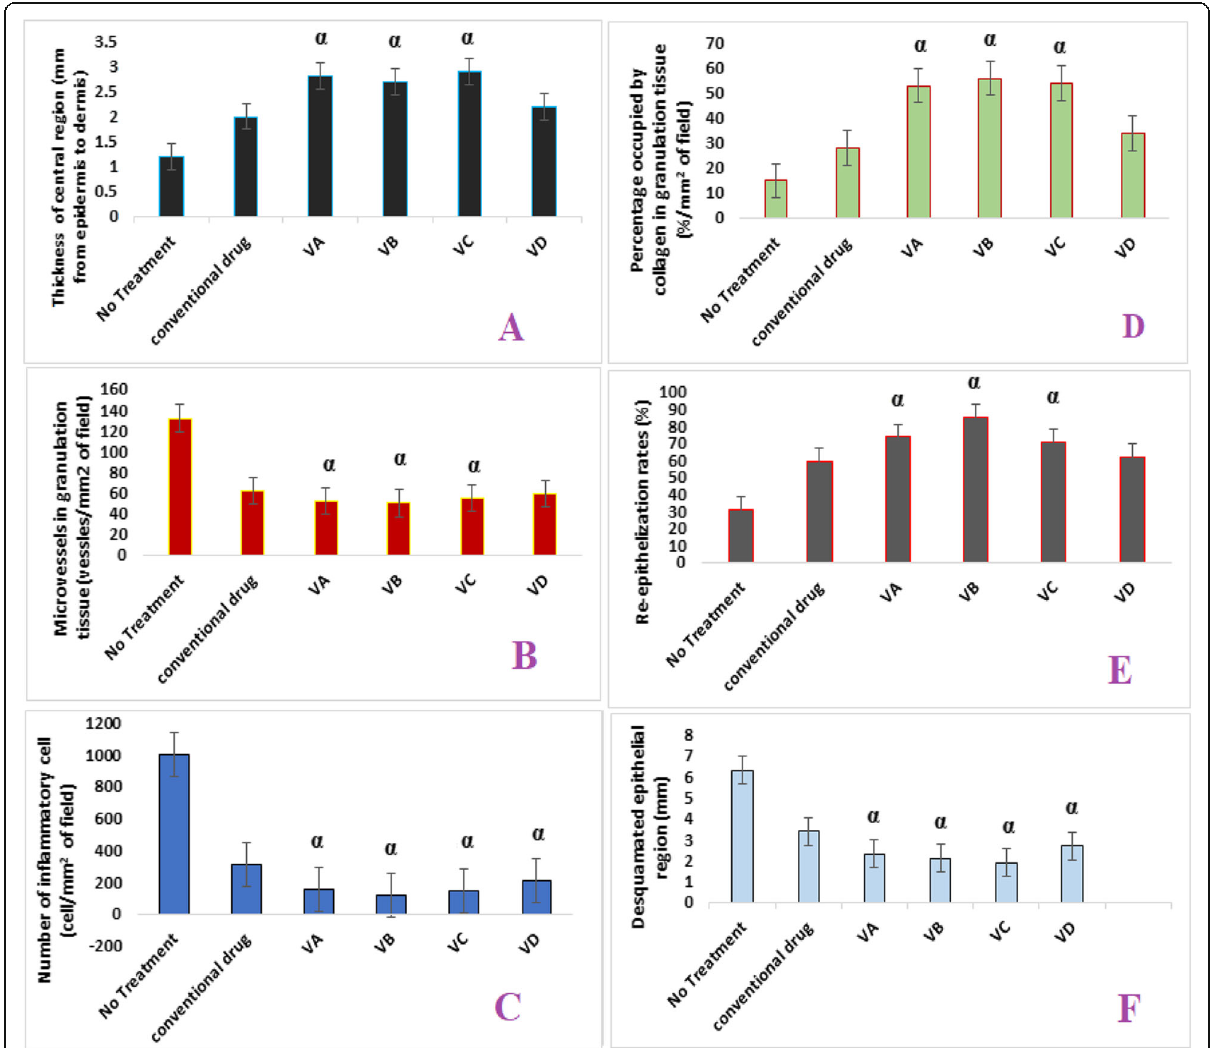
Fig. 6 Histomorphometrical values showing a thickness of central region (mm from epidermis to dermis), b microvessels in granulation tissue (vessels/mm 2 of field), c number of inflammatory cells (cell/mm 2 of field), d percentage occupied by collagen in granulation tissue (%/mm 2 of field), e re-epithelization rates (%), and f desquamated epithelial region (mm). Treatments were compared with control (conventional drug Sofratulle® containing 1% framycetin sulfate) ( α reflects significance, α p < 0.05. n = 4). The composition of PLA/HA-valsartan scaffolds VA, VB, VC, and VD is provided in Table